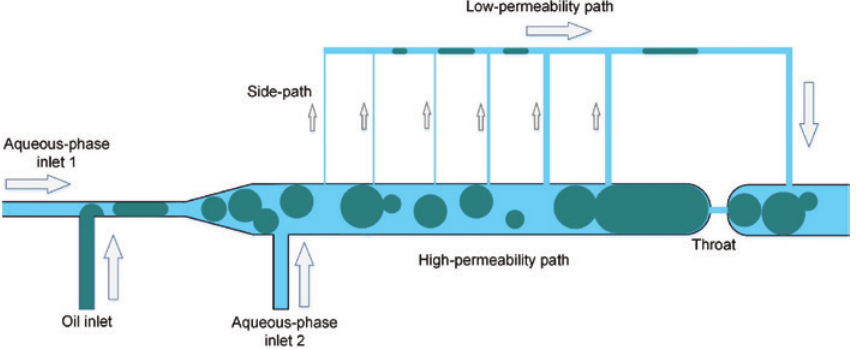
Figure 2: The schematic of the microfluidic design